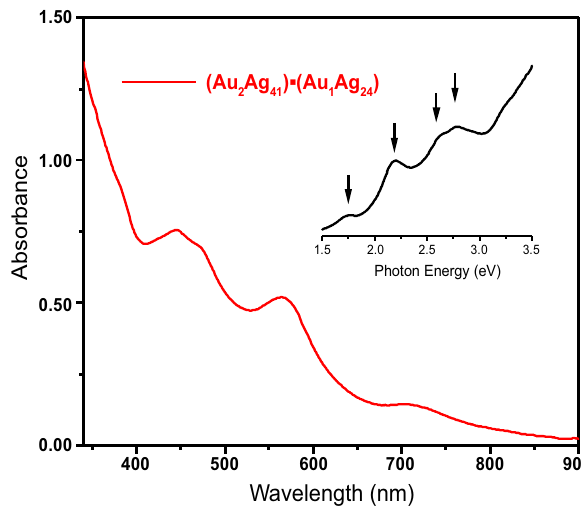
Fig. 1 UV − vis absorption spectrum of the (Au 2 Ag 41 ) ■ (AuAg 24 ) co- crystal dissolved in CH 2 Cl 2 . The insert shows the UV – Vis spectrum plotted on the photon energy